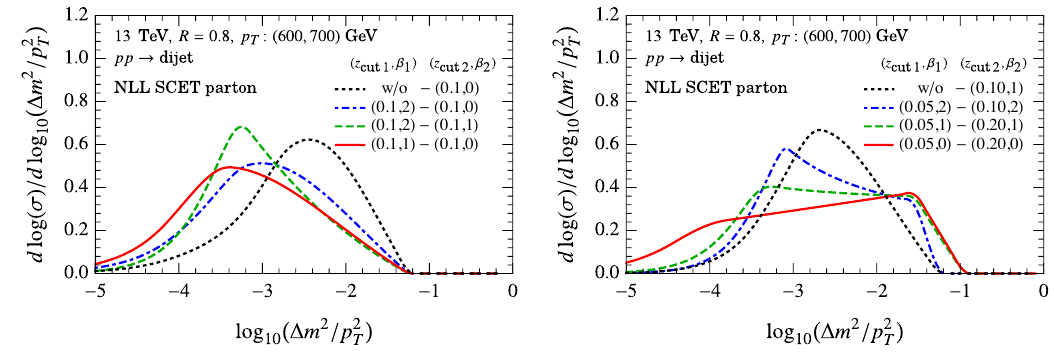
Figure 10 . Comparison of collinear drop distributions calculated using SCET. The left panel shows examples from varying the angular parameters (cid:12) i while holding z cut1 = z cut2 (cid:12)xed, whereas the right panel gives examples with varied z cut i with (cid:12)xed (cid:12) 1 = (cid:12) 2